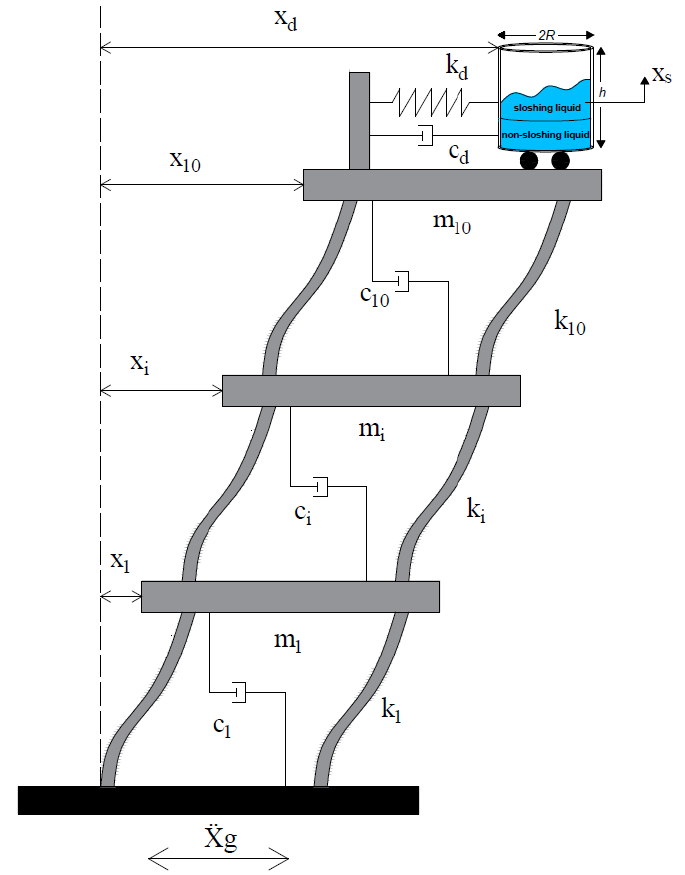
Figure 9. Cylindrical TLD plus 10-story structure model.